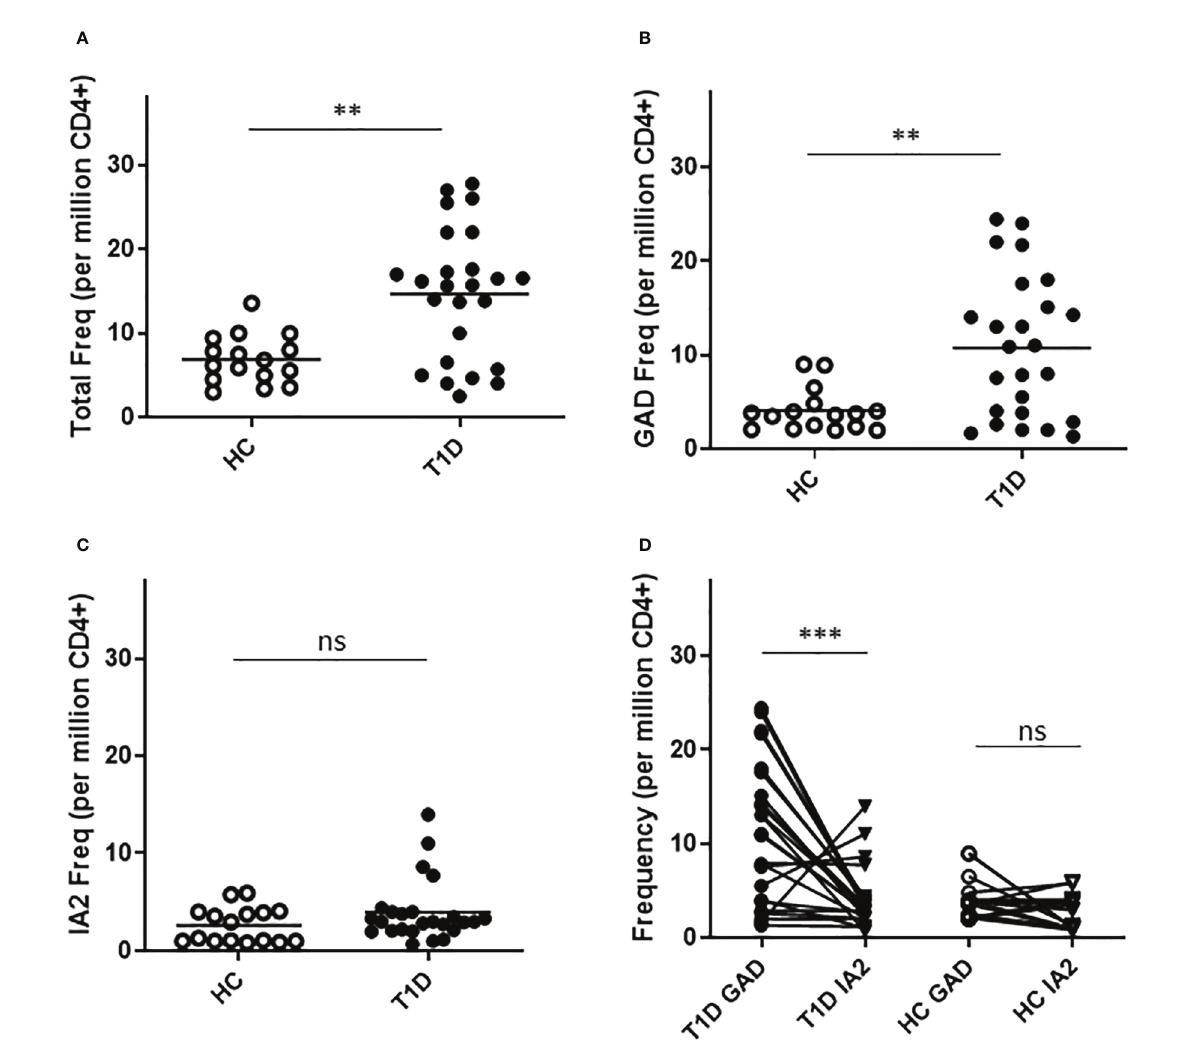
FIGURE 1 T cells speci fi c for PTM epitopes are more frequent in subjects with T1D. HLA class II tetramers were used to characterize T cells speci fi c for PTM GAD (DR0401 restricted) and PTM IA-2 (DQ8 restricted) epitopes in 25 subjects with T1D and 15 HLA matched control subjects. (A) Combining both groups of epitopes, total frequencies were signi fi cantly higher (p=0.0017, Mann Whitney test) in subjects with type 1 diabetes (black circles) than in HLA matched controls (white circles). (B) Examining PTM GAD and IA-2 epitopes separately, frequencies were signi fi cantly higher for PTM GAD (p=0.0069, Mann Whitney test) in subjects with type 1 diabetes (black circles) than in healthy controls (white circles). (C) In contrast, although four subjects had elevated frequencies, The frequency of IA-2 speci fi c T cells was not signi fi cantly higher (p=0.33, Mann Whitney test) in subjects with type 1 diabetes (black circles) than in healthy controls (white circles). (D) Performing a paired comparison of PTM GAD and PTM IA2 speci fi c T cell frequencies, PTM GAD frequencies were signi fi cantly higher than PTM IA2 frequencies in subjects with T1D (p=0.0004, Wilcoxon matched-pairs signed rank test), but were not signi fi cantly different in matched controls (p=0.22, Wilcoxon matched-pairs signed rank test). Horizontal lines in each panel indicate the mean value for each group. ns indicates "not signi fi cant" (p-value >0.05) * indicates p-value below 0.05 but above 0.01 ** indicates p-value below 0.01 but above 0.001 *** indicates p-value below 0.001 but above